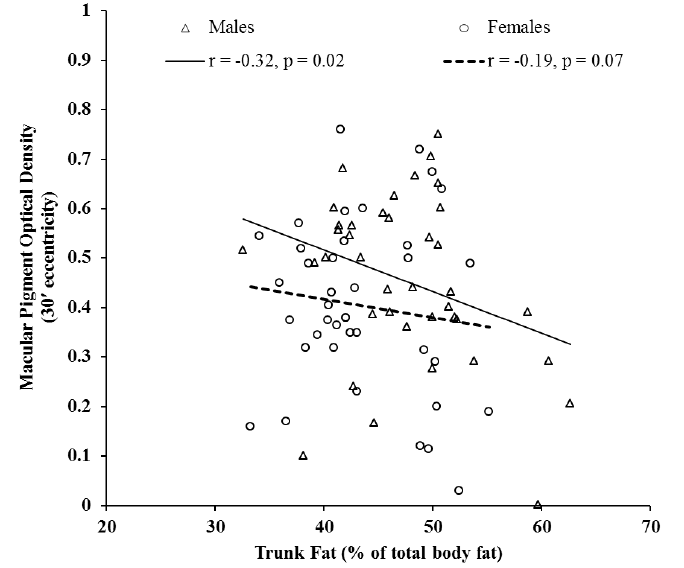
Figure 2. The relationship between MPOD at 30  eccentricity and the percentage of total body fat that accumulated in the trunk region for male ( N = 39) and female ( N = 61)